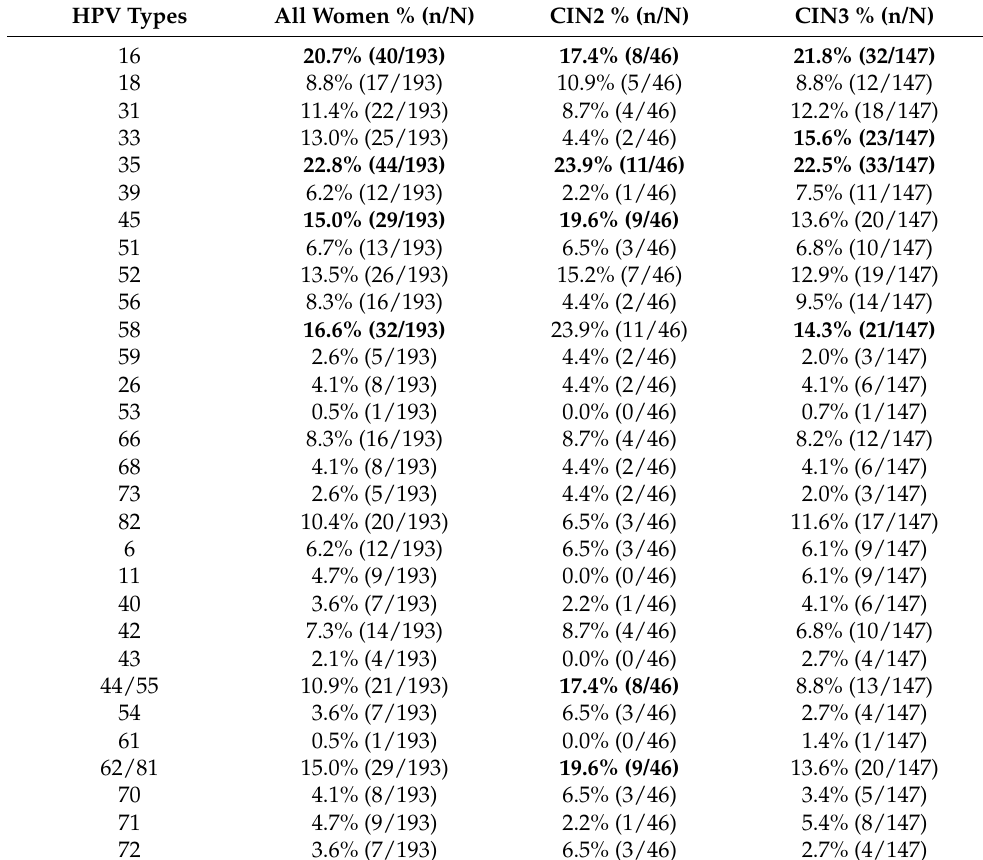
Figure 2. Distribution of single and multiple HPV types according to age in women with CIN2 ( A ) and CIN3 ( B ).